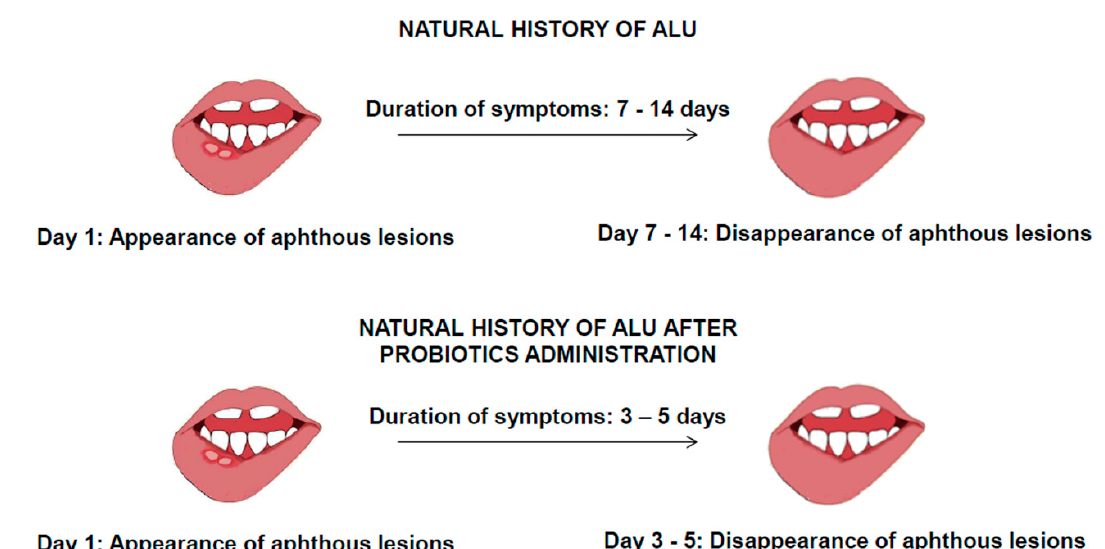
Figure 5. Probiotics as effective therapy for ALU. Hypothesis: Restoration of eubiosis can dramatically contribute to remission of ALU by contrasting pathogenic phenomena.